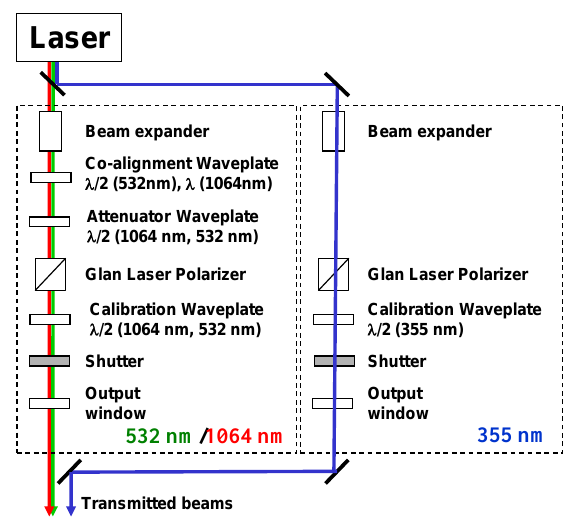
Figure 1. A simplified block diagram of the transmitter optics relevant for linear depolarization measurements by HSRL-2. The two Glan laser polarizers are the primary components ensuring the transmitted laser light is polarized. The motorized calibration wave plates are used to align the output polarization to the receiver po- larization analyzers. The 532 and 1064nm laser beams are main- tained as a single beam. Since they do not exit the laser at the same polarization, a co-alignment wave plate is used to align the polar- ization from the two wavelengths so that the Glan laser polarizer does not significantly reduce the amount of light transmitted at one of the wavelengths. The attenuator wave plate is used to attenuate the 532nm beam for eye safety considerations when flying at low altitudes, and for maximizing the power output